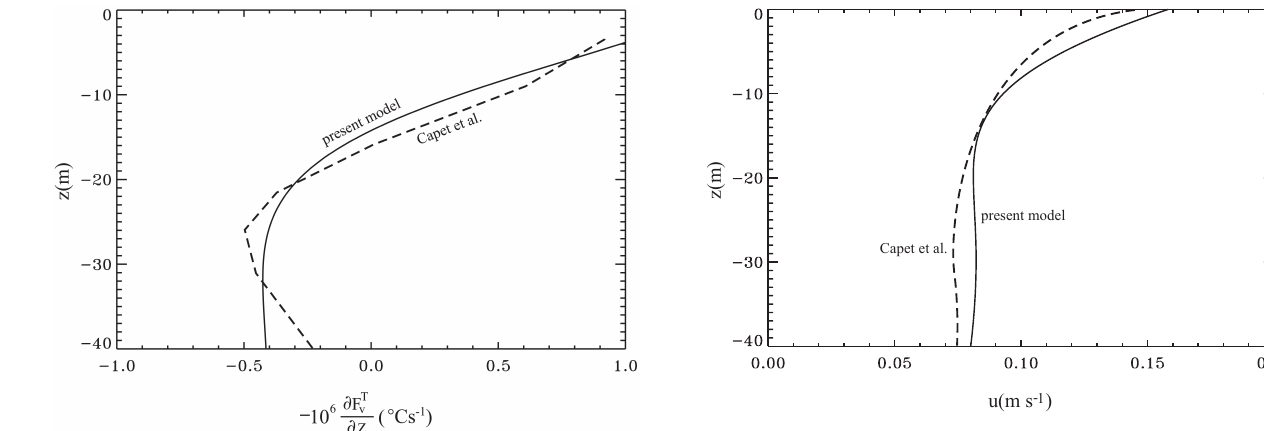
(z) for ICC0 simulation data by Capet et al. (2008) Fig. 1. − ∂ z F T V (dashed curve taken from their Fig. 12) and for the present model (Eq. 12a) (solid curve).